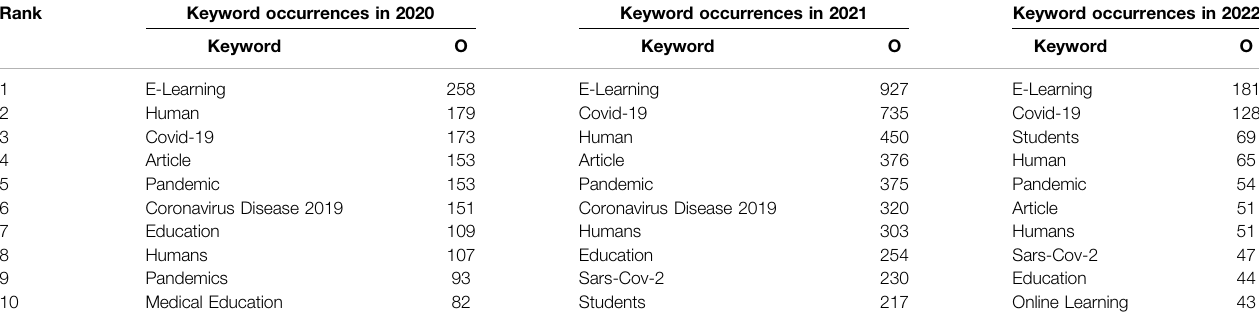
TABLE 8 | Top 10 used keyword occurrences in different